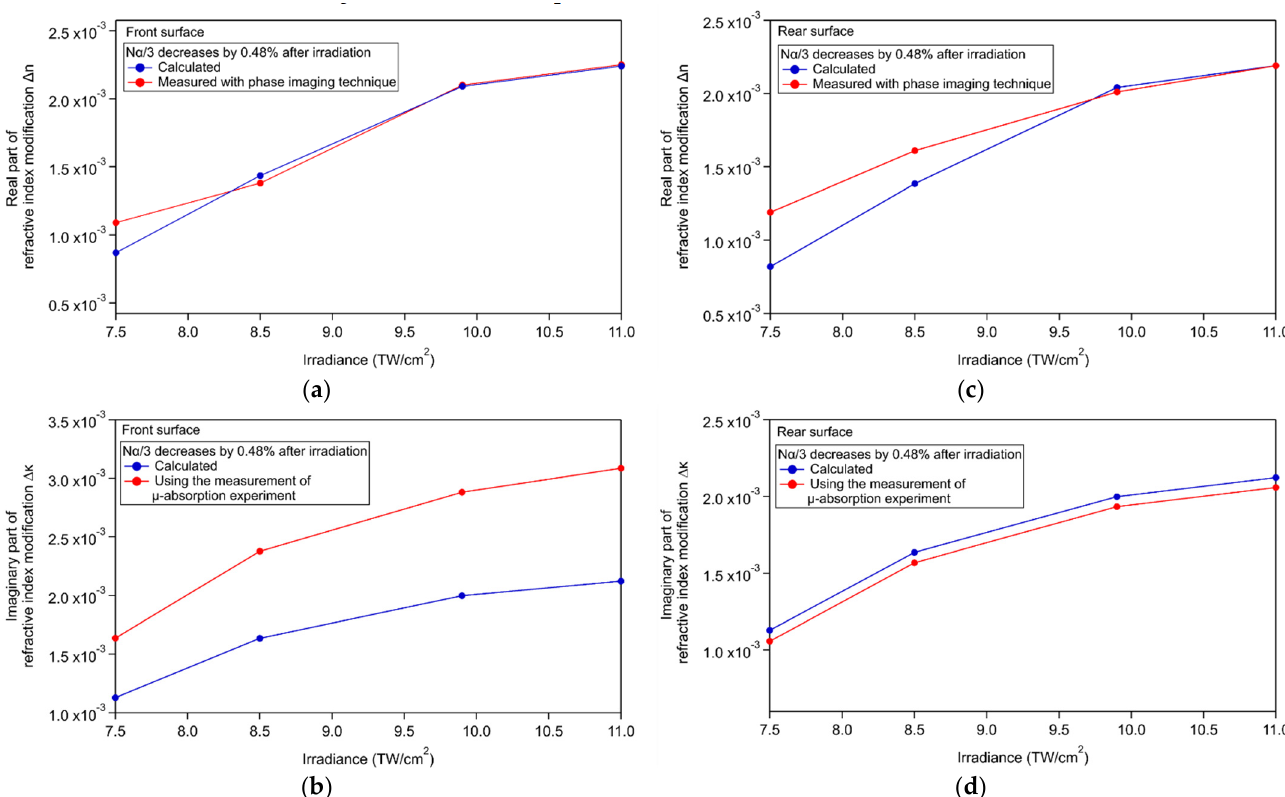
( b , d ) their imaginary counterparts ∆ κ ,